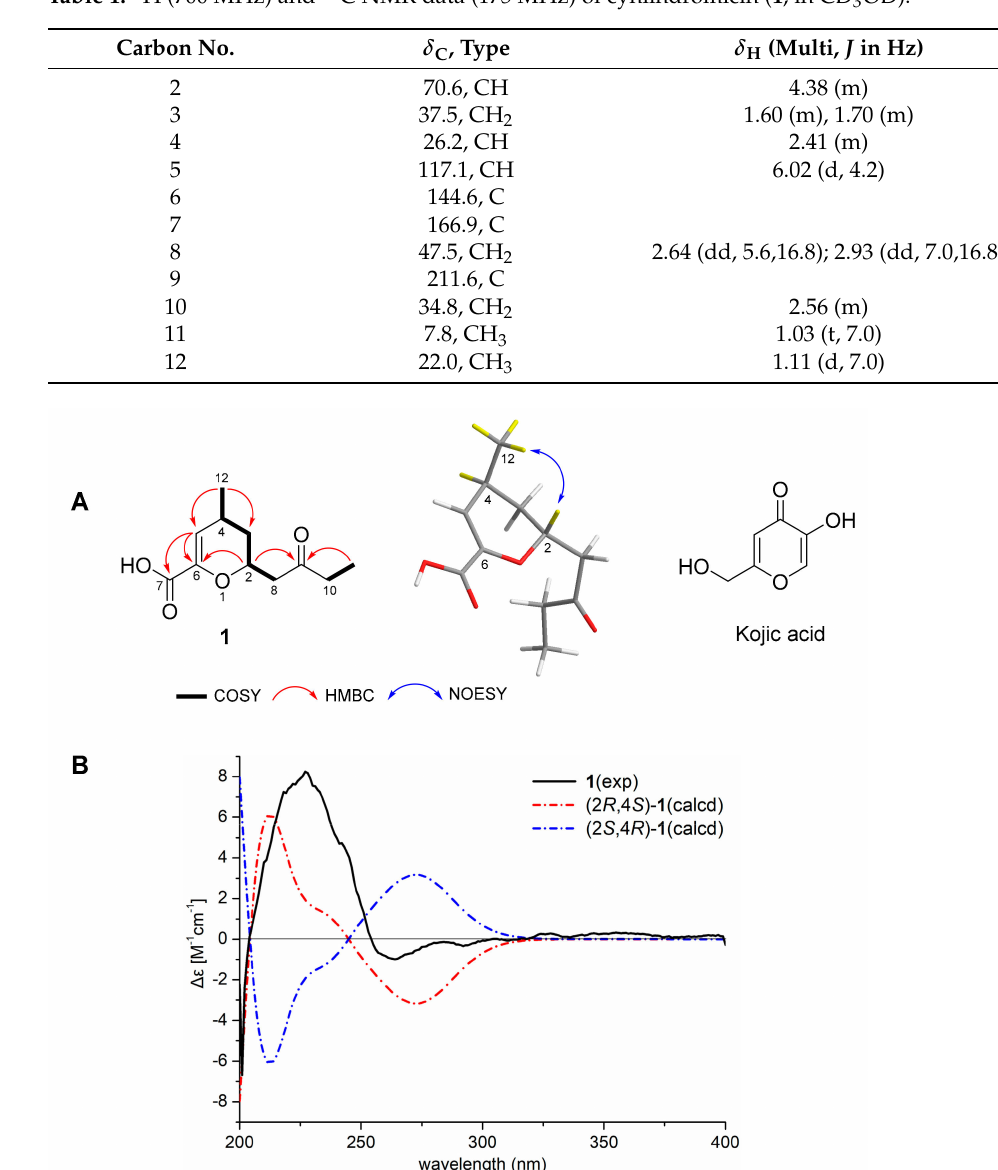
Figure 2. Selected key COSY, HMBC, and NOESY correlations of compound 1 ( A ) and comparison of experimental ECD spectra of 1 with the calculated one for 2 R , 4 S configurations ( B